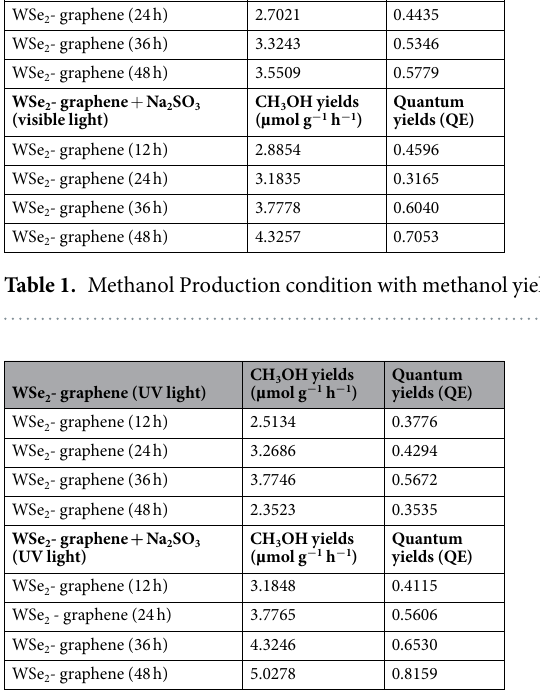
WSe 2 -graphene (visible light)